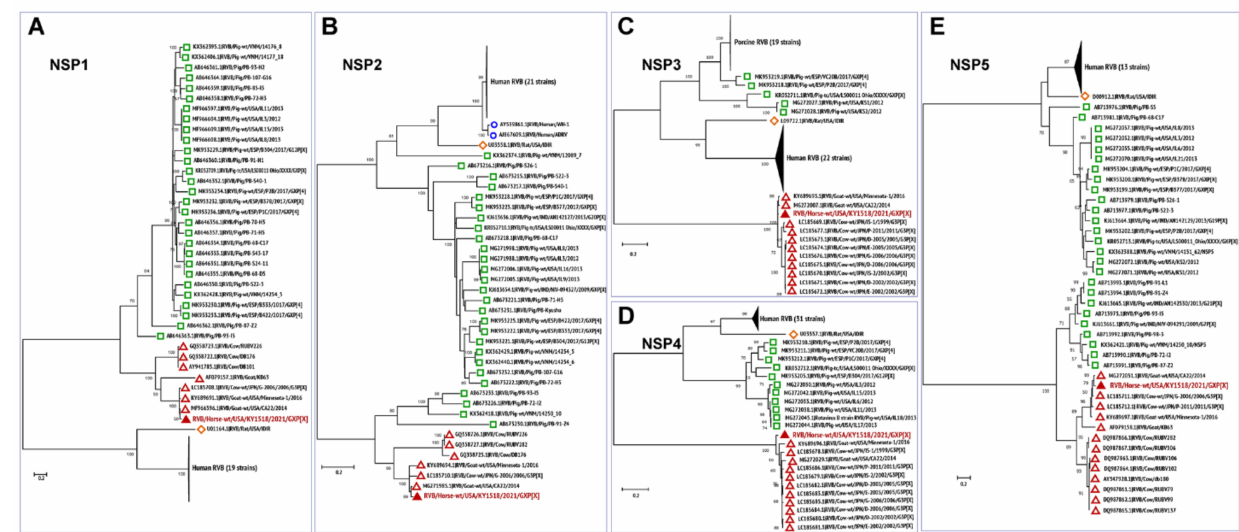
Figure 4. Phylogenetic trees of the complete protein-coding nucleotide sequences of the group B rotavirus VP4 ( A ), VP6 ( B ), VP7 ( C ), NSP4 ( D ), and NSP5 ( E ) genes. Maximum-likelihood analysis in combination with 1000 bootstrap replicates was used to derive trees based on the nucleotide sequences encoding respective proteins. The RVB strains are color-coded as human (blue open circle), murine (open orange diamond), porcine (green open square), and ruminant (red open triangle), with RVB/Horse-wt/USA/KY/1518/2021 (filled red triangle) highlighted in red font. A scale bar representing the number of nucleotide substitutions per site is also shown in each panel. Bootstrap values are shown above branches to the left of major